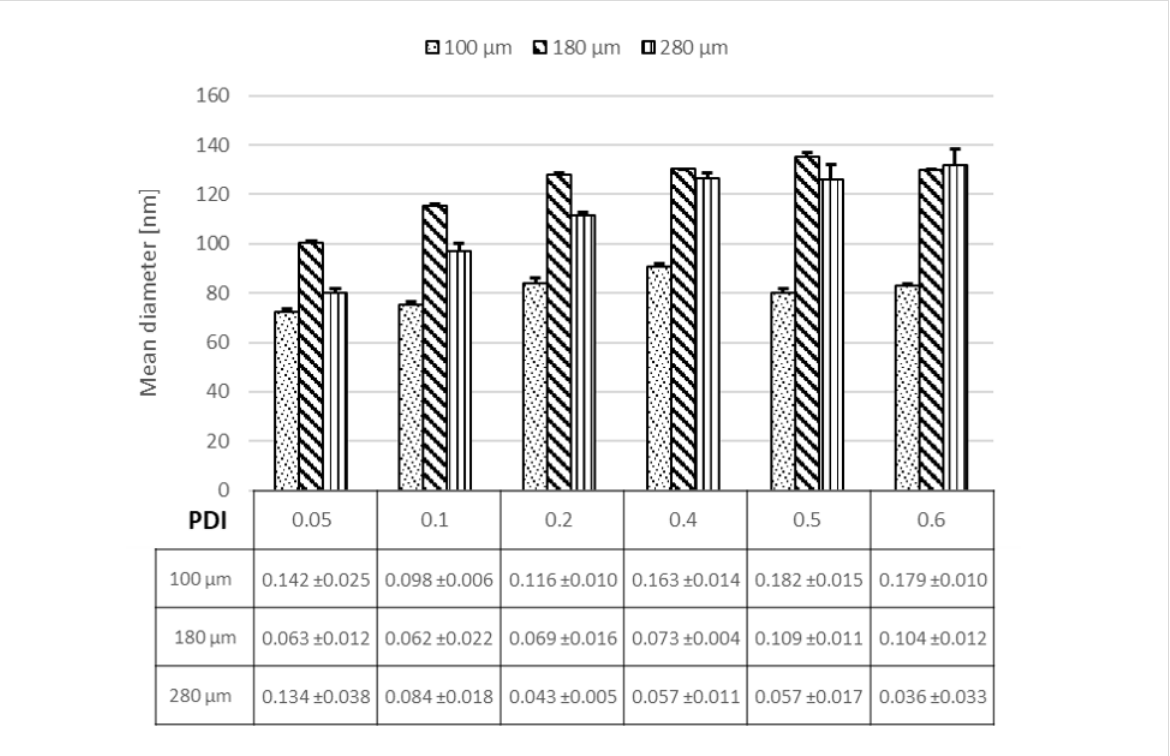
Figure 4: Effect of adjusting the diameter of the focusing channel (100 µm, 180 µm and 280 µm) on NP size and size distribution at different flow rate ratios.